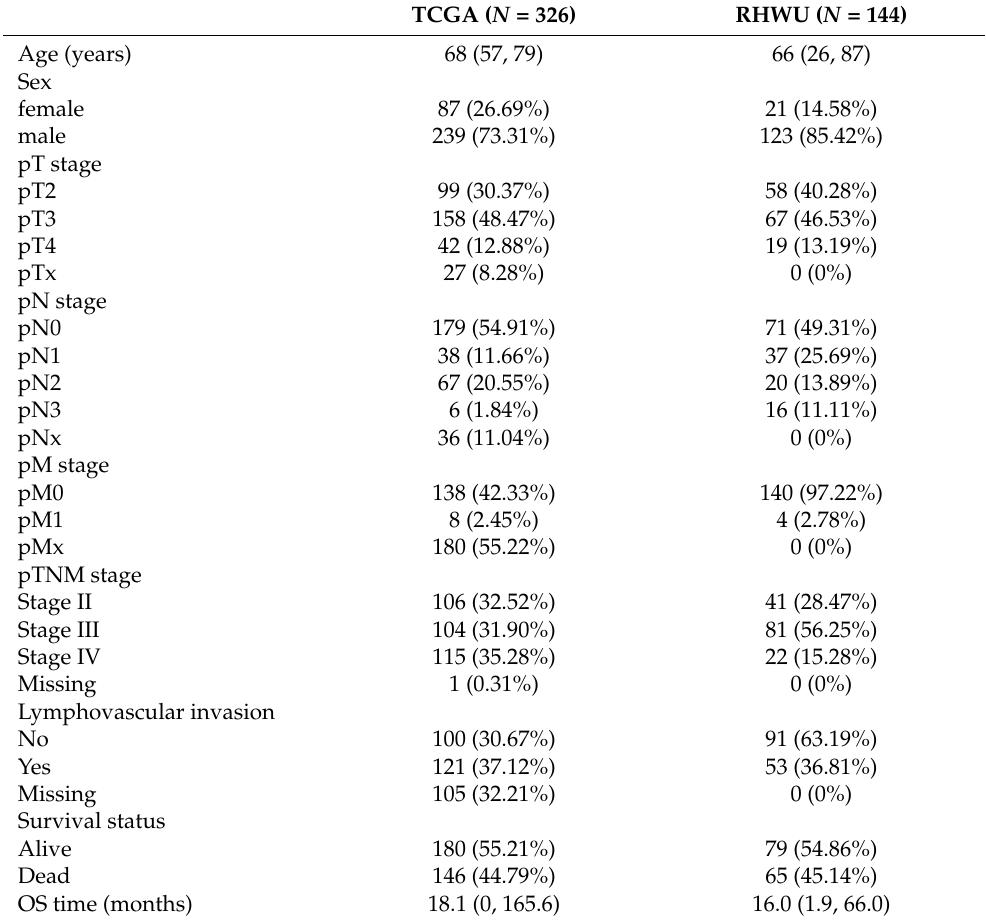
Table 1. Clinical, biological, and pathological features of the MIBC patients included in the prognostic model